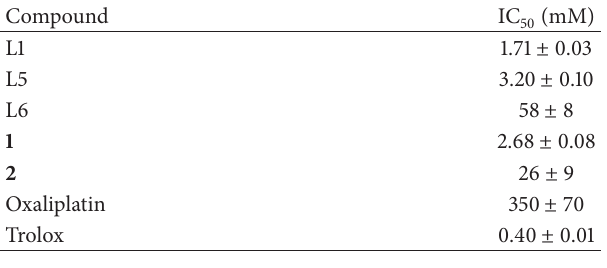
) of compounds L5, L6, 1, 50